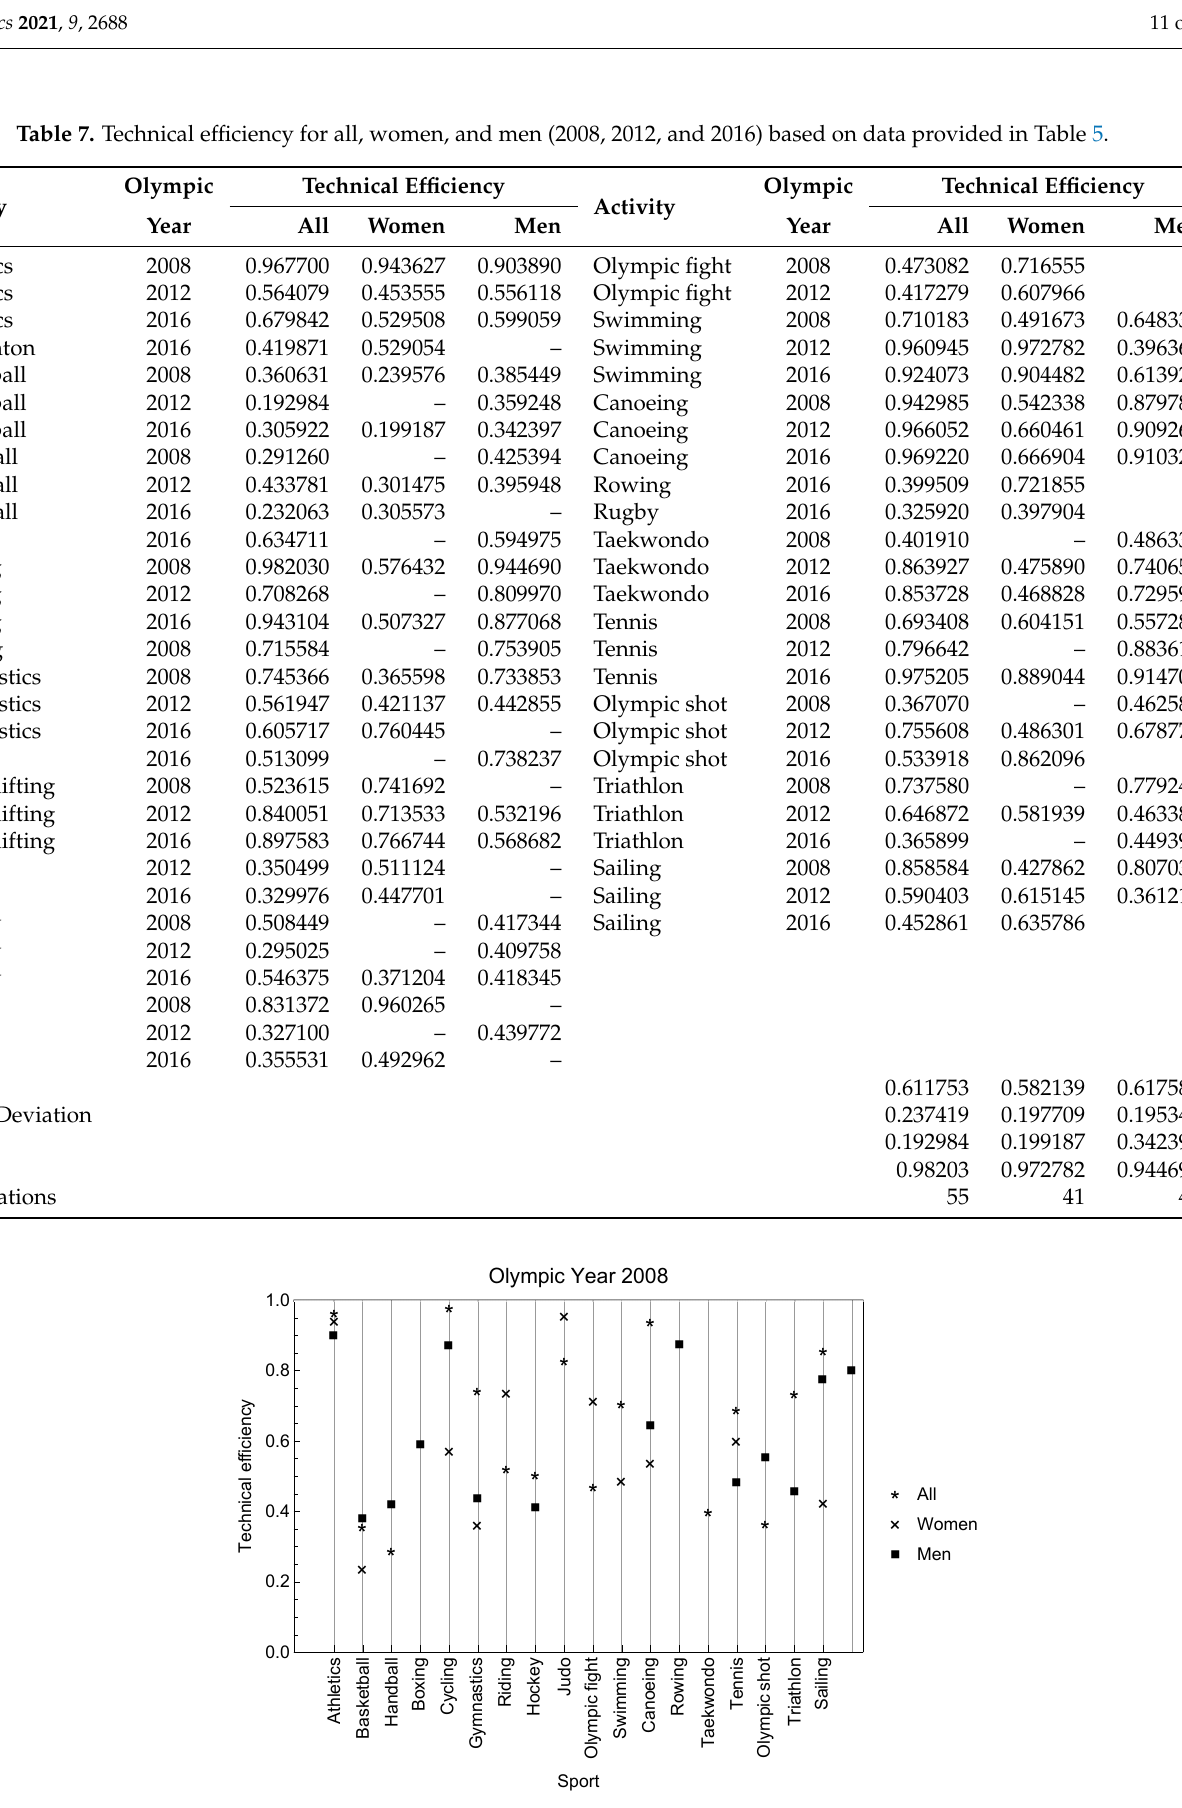
Figure 2. Technical efficiency (Olympic year